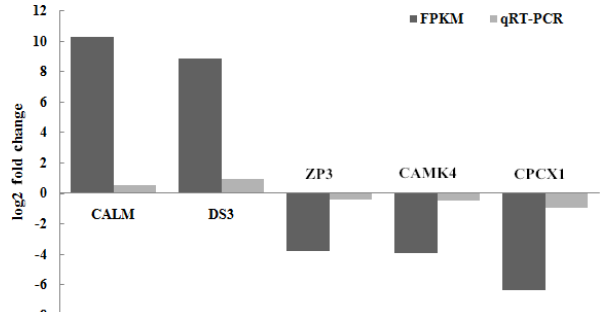
Figure 6. Validation of the RNA-seq data by real-time PCR for selected genes. FPKM is a commonly used method to estimate gene expression levels in transcriptome data analysis; log2 (fold change) is the logarithm of the difference in gene expression between two samples which is used to measure differences in